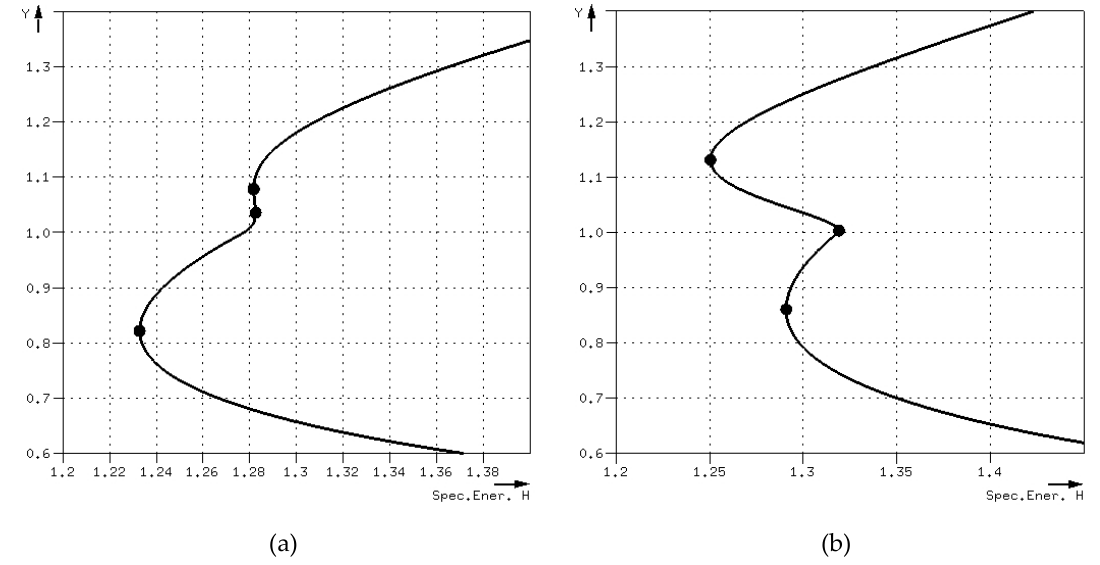
Figure 12. Specific energy and critical depths of: ( a ) a typical compound section of dataset 2; ( b ) the compound section of Figure 10.